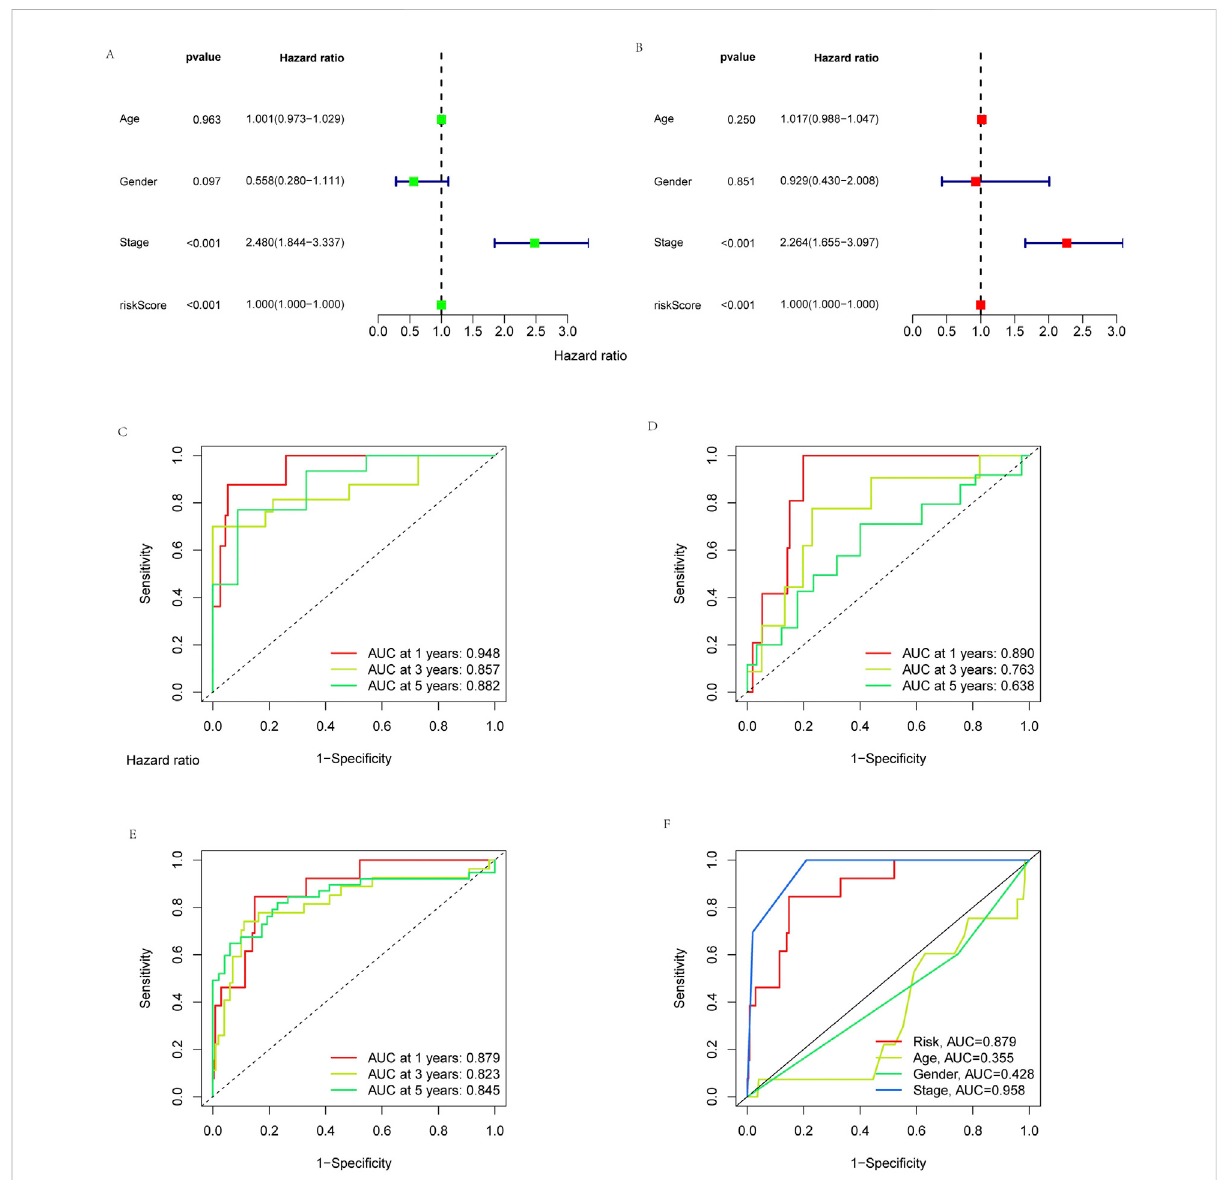
FIGURE 5 Independent analysis of prognosis factor. The prognosis value of the signature for KIRP. (A) Univariate and (B) multivariate independent prognosis analysis to analyze whether the risk score was independently associated with OS. 1-, 3-, and 5-year area under the ROC curve (AUC) of signature in the (C) training, (D) testing, and (E) all groups. (F) ROC curves for the risk score (AUC = 0.879) and other clinical